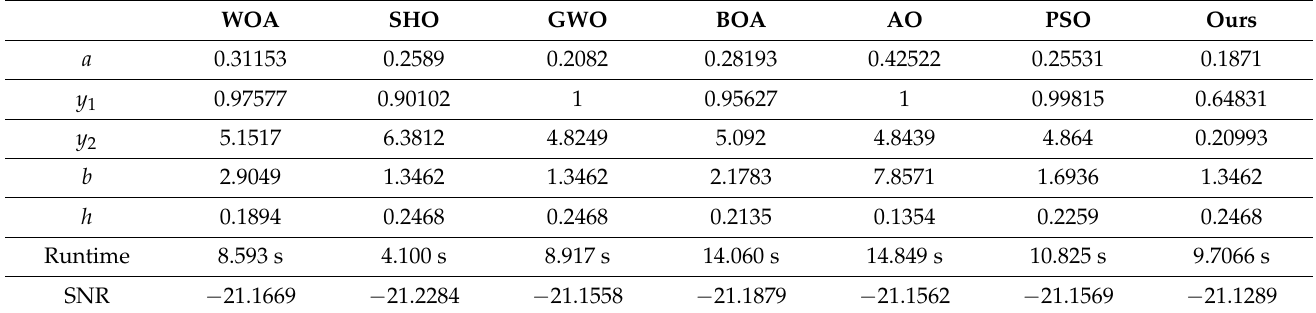
Table 6. Experimental parameter